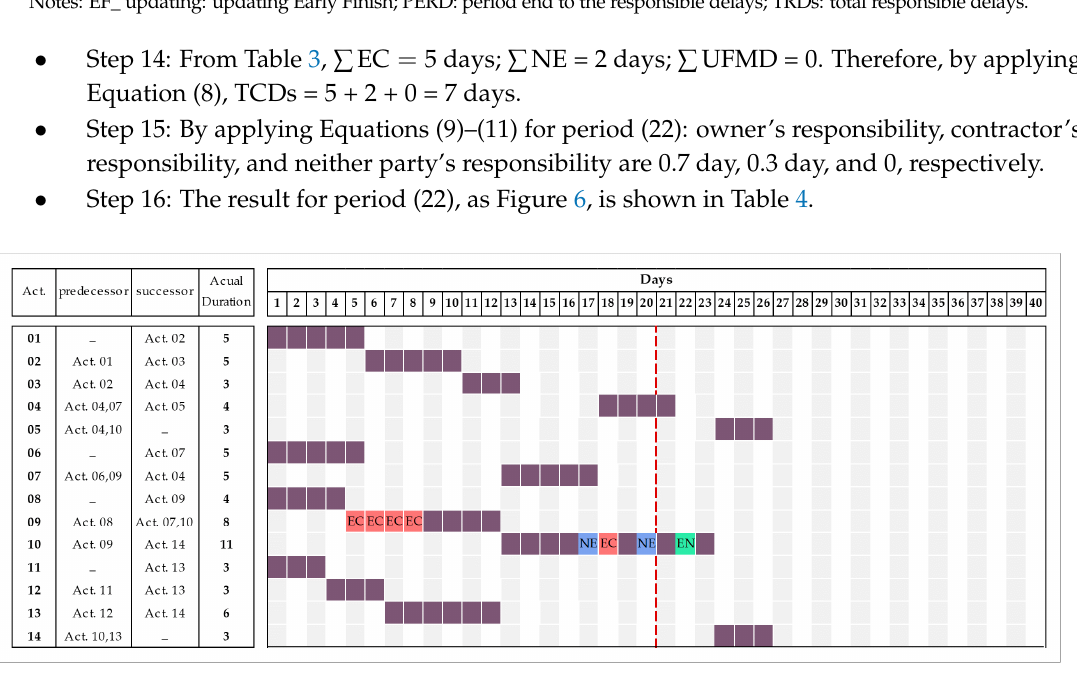
Figure 6. As-planned impacted schedule, period (22).